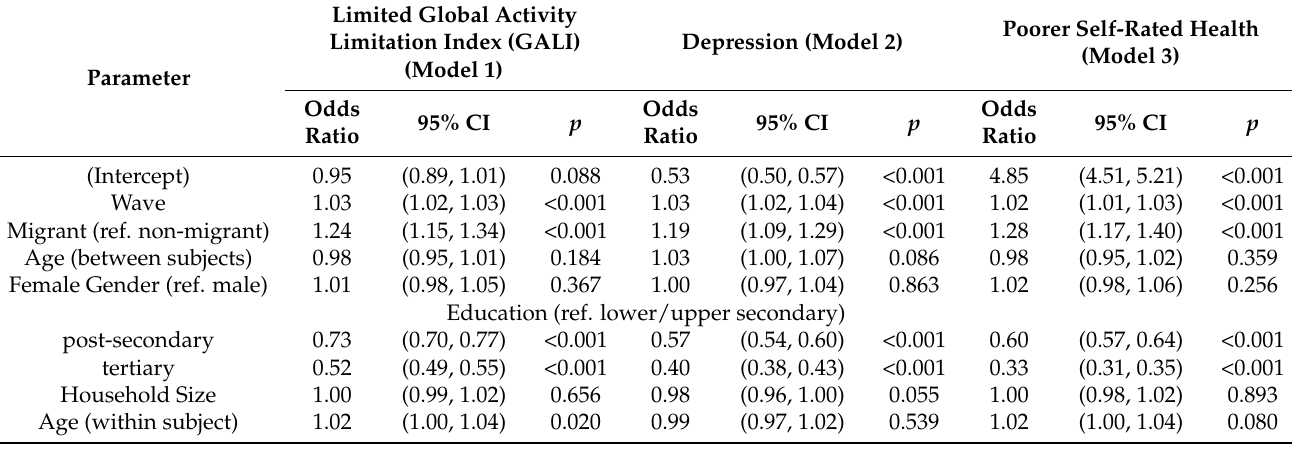
Table 2. Logistic regression models with survey design for GALI (model 1), depression (model 2) and self-rated health (model 3) (SHARE, waves 1, 2, 4–7, n = 233,117); odds ratios, 95% confidence intervals (CI) and significances ( p ).